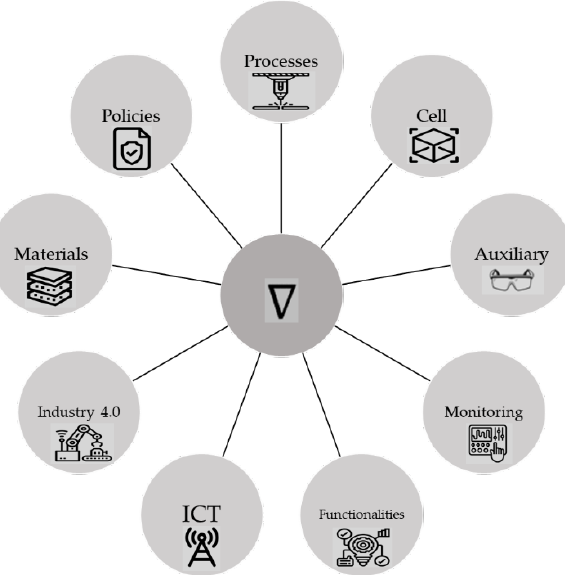
Figure 4. The first level of technologies’ classification. Table 1. Indicative ontology towards workflow